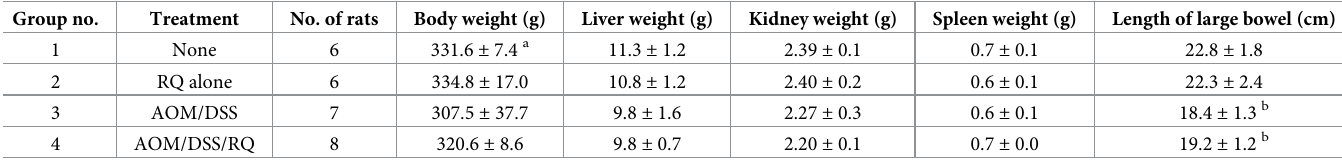
Table 1. General observations of the experimental rats. Group